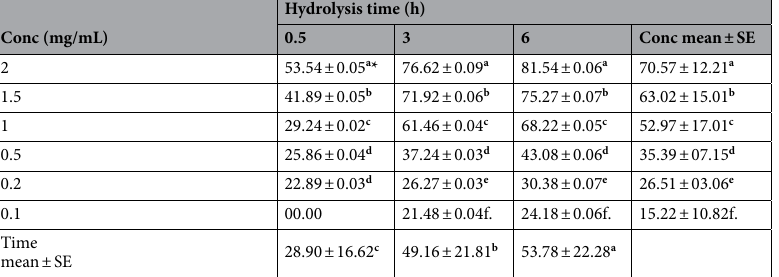
Table 6. Radical scavenging activity of xylo-oligosaccharides at different concentrations and hydrolysis time toward DPPH. * Radical scavenging activity given as percentage inhibition. The percentage inhibition of the standard ascorbic acid was 100%. Values are means of three replicates and the relative standard deviations ˂ 1%. Means followed by the same letter(s) within a column are not significantly different (p ≤ 0.05) according to Duncan’s multiple range